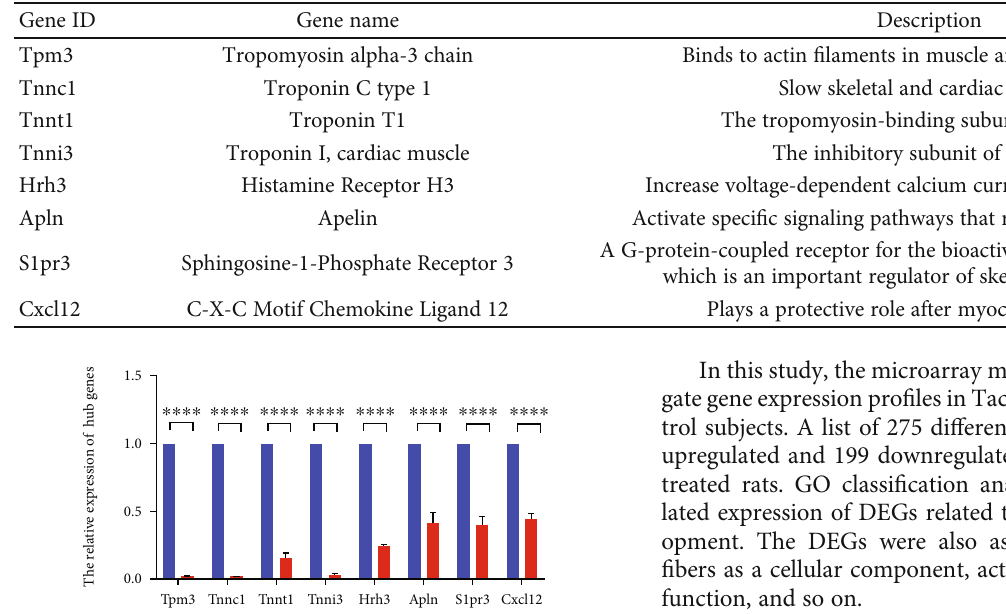
Table 4: Functional annotation of hub genes.